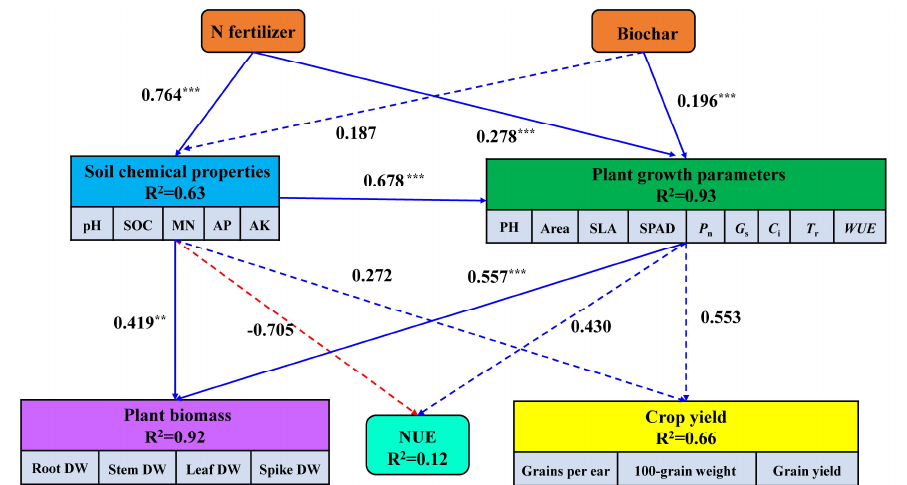
Figure 7. Structural equation model explaining the plant biomass, NUE and crop quality of maize (χ 2 = 1097.1, NFI = 0.47). Standardized path coefficients are shown next to the arrows. Solid-line arrows indicate significant paths; dotted-line arrows indicate non-significant paths; blue-line arrows indicate positive relationships; red-line arrows indicate negative relationships; values associated with the line represent standardized path coefficients. The R2 numbers within boxes denote the proportion of variance that could be explained by the corresponding variable in the structural equation model. Significance levels are indicated: ** p < 0.01, *** p < 0.001.